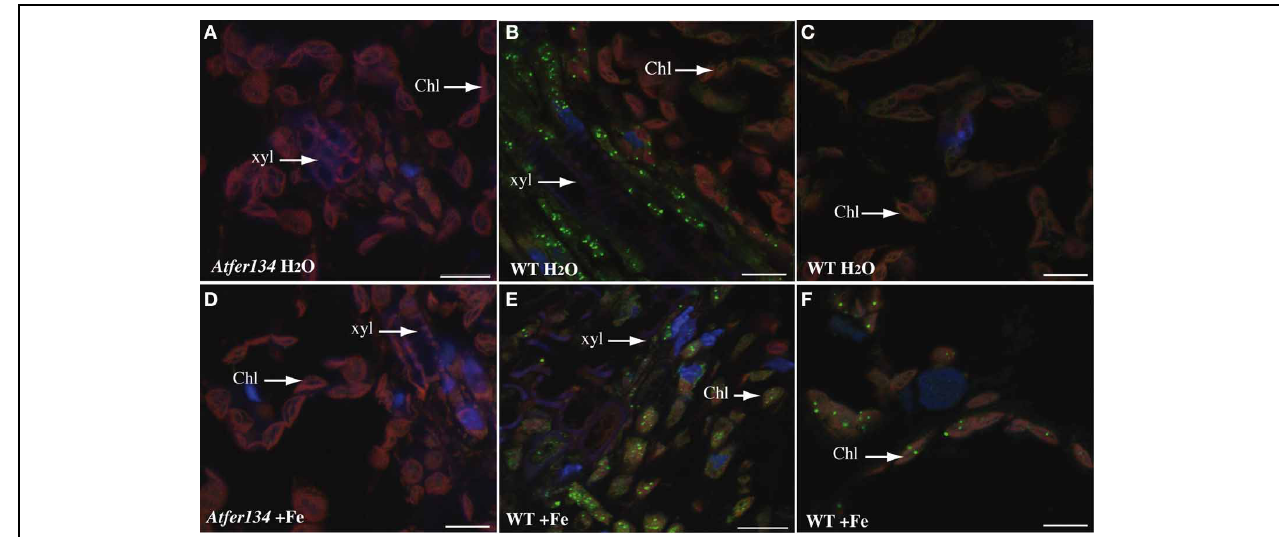
FIGURE 4 | Immunolocalization of Ferritin in Arabidopsis leaves. Sections of rosette leaves from 3 week-old WT (B,C,E,F) or triple mutant At fer1,3,4 (A,D) plants irrigated with either water (A–C) or 2mM Fe-EDDHA (D–F) were probed with an anti-ferritin antibody and revealed with a secondary anti-rabbit